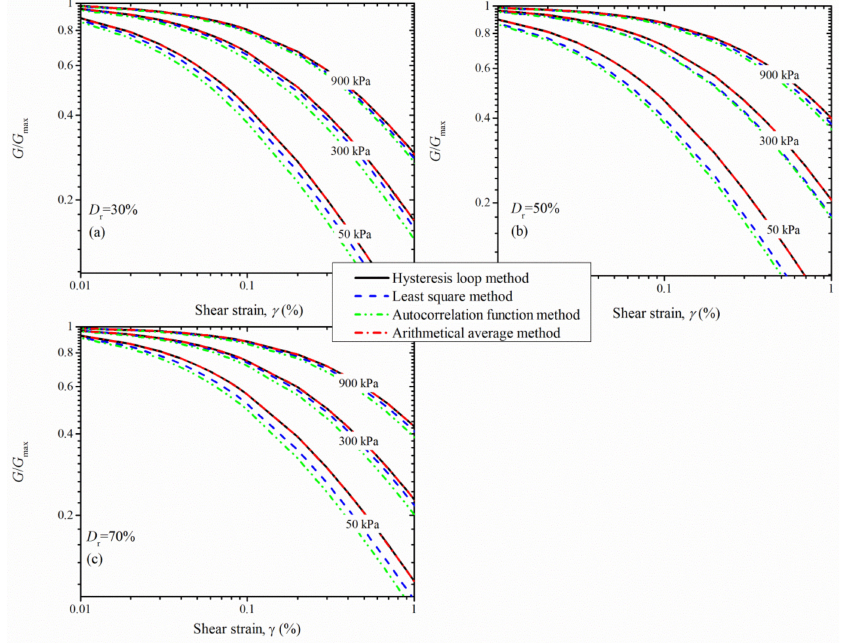
Figure 10. Representative G / G max - γ curves for four determination methods ( D r = 30, 50, 70% and σ c = 50, 300, 900